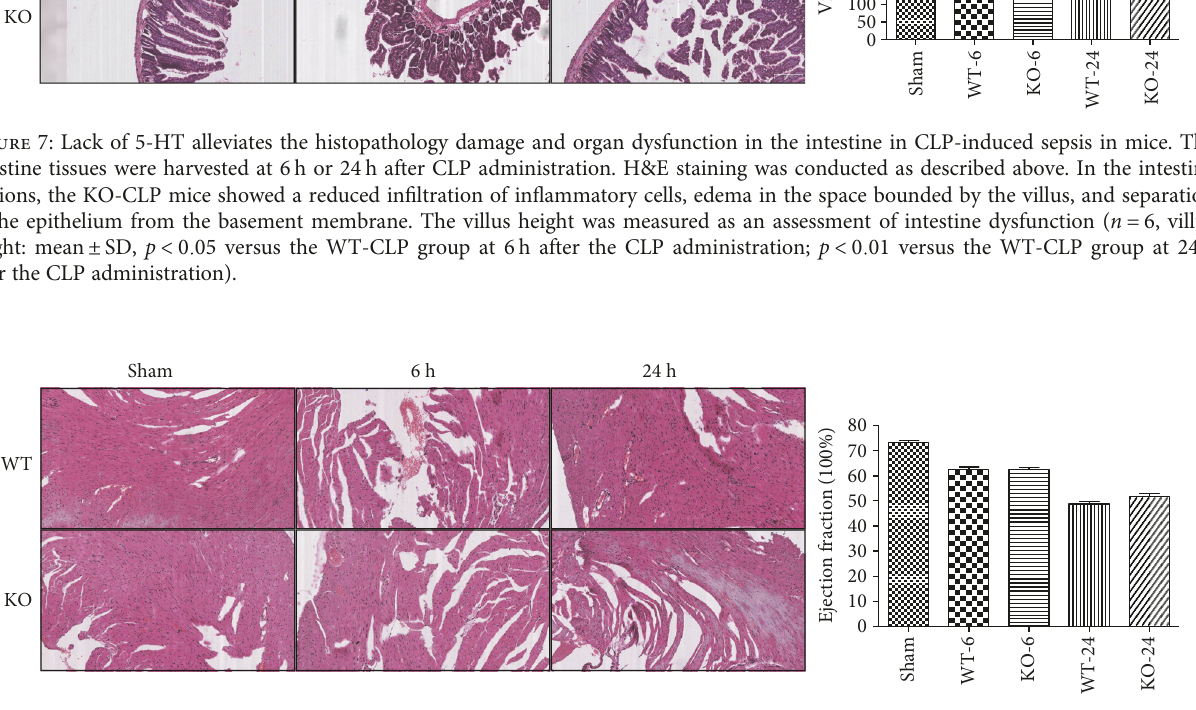
Figure 8: Lack of 5-HT alleviates the histopathology damage and organ dysfunction in the heart in CLP-induced sepsis in mice. The animal heart tissues were harvested at 6 h or 24 h after CLP administration. H&E staining was conducted as described above. In the heart, the KO-CLP mice showed less in fl ammatory cell in fi ltration, necrosis, and degeneration than the WT-CLP mice. The ejection fraction was measured as an assessment of heart dysfunction ( n = 6 , ejection fraction: mean ± SD; there has no signi fi cant di ff erence at both 6 h and 24h after the CLP administration).